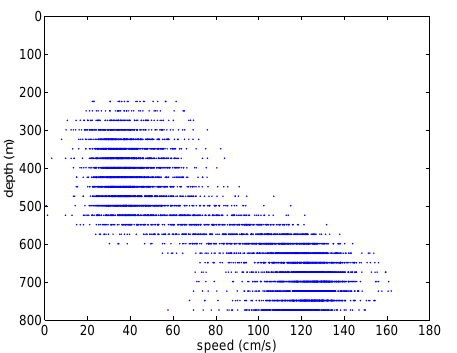
Fig. 5. Vertical distribution of the daily maxima taken into account for applying the GEV distribution, at location FB. Values of speed (cms − 1 ) are obtained by summing surge and mean residual flow.